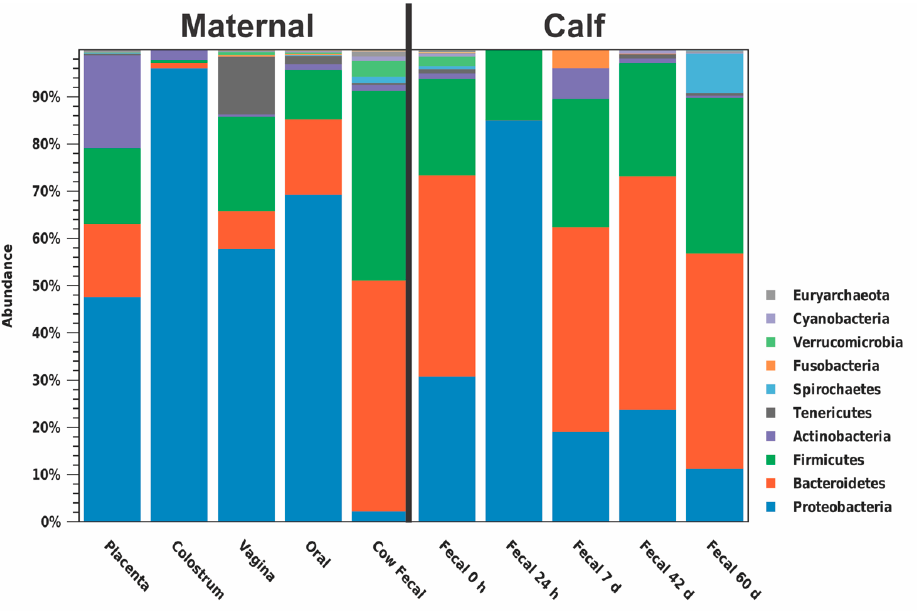
Figure 3. Relative abundance of phyla in each multiparous Holstein maternal (placenta, colostrum, oral, fecal, n = 6; vaginal, n = 4) and calf (meconium, 24 h, 7d, 42 d, and 60 d fecal; n = 6) sample type. Proteobacteria were the dominant phylum within placenta, vagina, colostrum, oral, and 24 h calf fecal samples, while Bacteroides were the dominant phylum in dam fecal, meconium, 7 d, 42 d, and 60 d calf fecal samples.